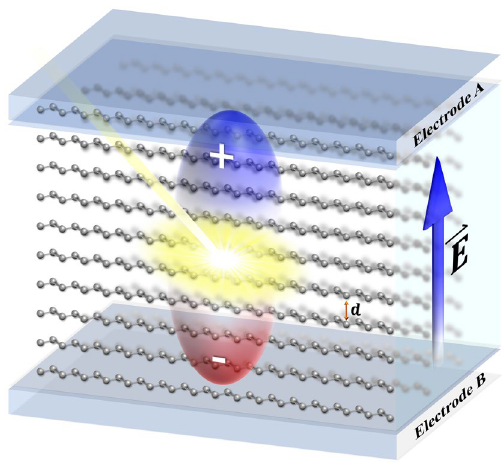
Figure 1. Schematic diagram of the polymer array